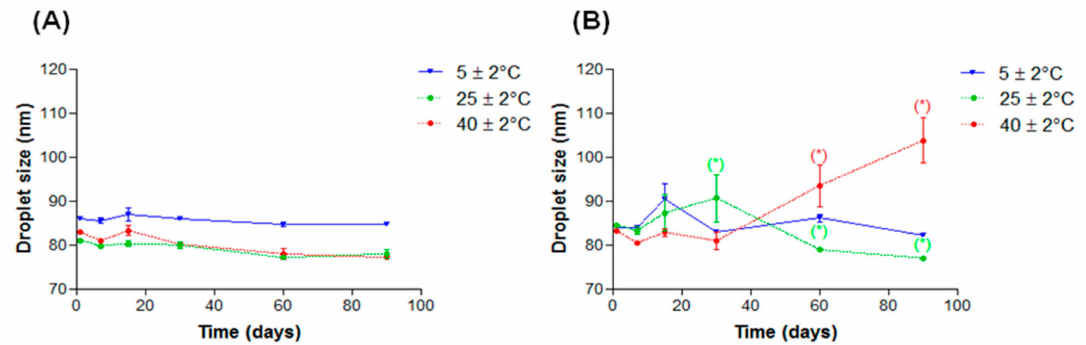
Figure 6. Droplet mean sizes in function of time of nanoemulsions with added lanolin derivatives subjected to different storage temperatures: ( A ) EL and ( B ) AL. * p > 0.05.